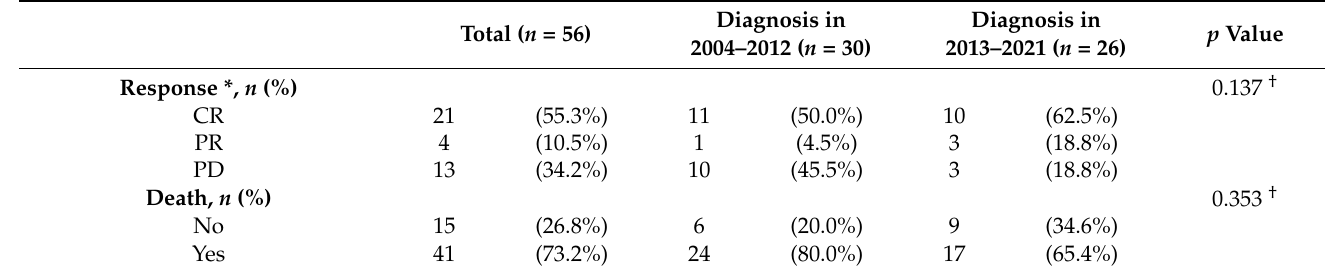
Table 3. Comparison of treatment outcome by first line intent-to-cure therapy.